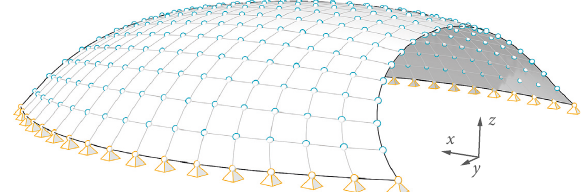
Figure 9: Fixed nodes at the